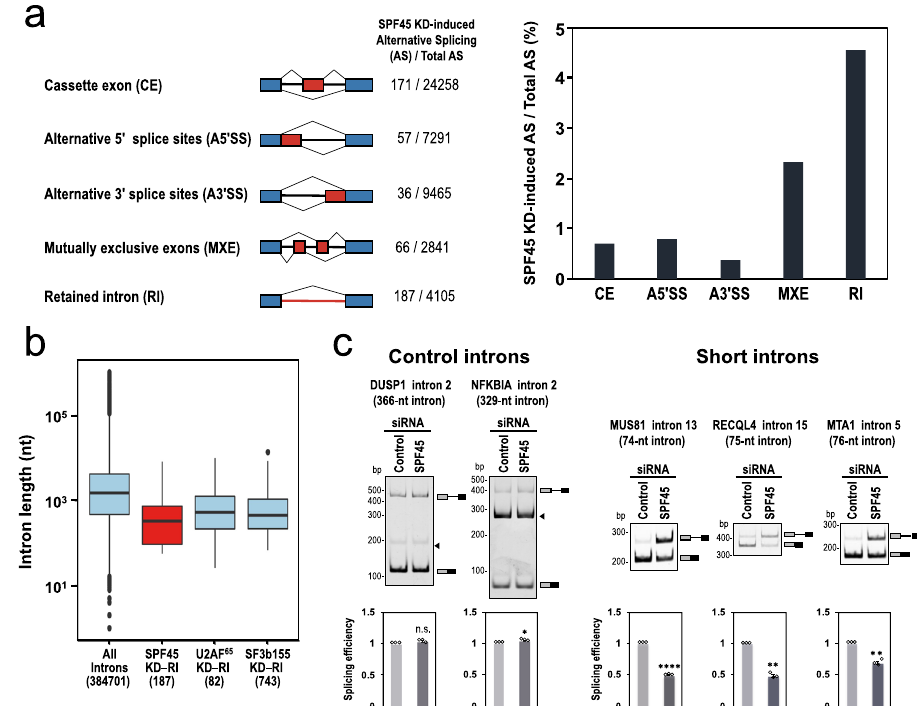
Fig. 2 SPF45 is generally required for splicing of pre-mRNAs including short introns. a RNA-Seq data exhibit deferential splicing patterns between control siRNA- and SPF45 siRNA-treated HEK293 cells. The numbers of signi fi cant splicing changes and total splicing events are indicated and the ratios are shown on the right. b Boxplots are comparing the intron-length distributions of all introns in human RefGene with those of the retained introns in SPF45-knockdown HEK293 cells. The retained introns in U2AF 65 - and SF3b155-knockdown HeLa cells obtained from the RNA-Seq data in GEO database are shown for comparison (signi fi cant for all pairs, P < 0.05). The numbers of introns are indicated in parentheses. Boxplots show the summary of the dataset; median (middle line), 25 – 75th percentile (box), and <5th and >95th percentile (whiskers), together with outliers (single points). c SPF45- knockdown selectively repressed splicing of pre-mRNAs with short introns. After the siRNA transfection in HEK293 cells, endogenous splicing of the indicated two control introns and three short introns were analyzed by RT-PCR. Arrowheads indicate nonspeci fi c PCR products. Means ± SEM are given for three independent experiments and two-tailed Student t -test values were calculated (DUSP1 intron: p = 0.0951 for Control vs SPF45 siRNA; NFKBIA intron: p = 0.0236 for Control vs SPF45 siRNA; MUS81 intron: p = 0.00004 for Control vs SPF45 siRNA; RECQL4 intron: p = 0.0019 for Control vs SPF45 siRNA; MTA intron: p = 0.0067 for Control vs SPF45 siRNA). * P < 0.05, ** P < 0.01, **** P < 0.0001, n.s. (not statistically signi fi cant) P > 0.05. Source data of all the above panels are provided as a Source Data fi